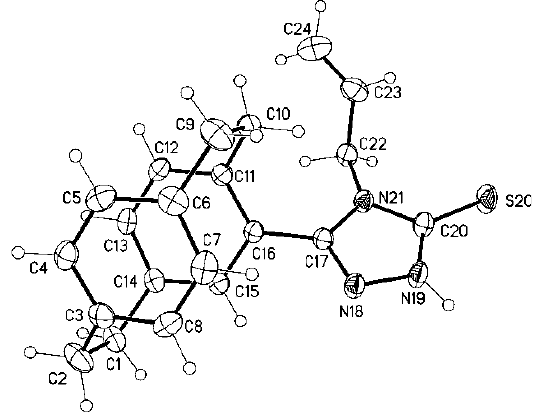
Figure 7. Molecular structure of compound 12d identified according to the IUPAC nomenclature as 5-(1,4(1,4)-dibenzenacyclohexaphane-12-yl)-4-allyl-2,4-dihydro-3 H -1,2,4-triazol-3-thione (solvent omitted for clarity; displacement parameters are drawn at a 50% probability level).